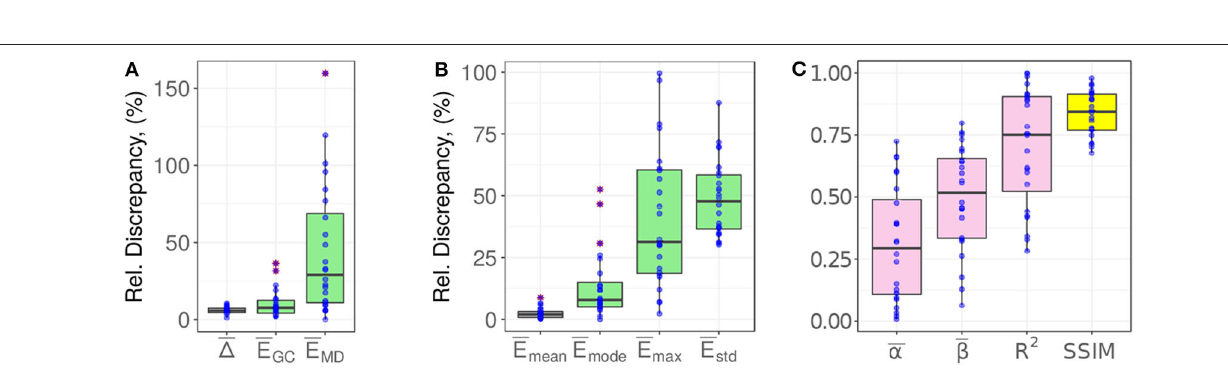
FIGURE 10 | Combined comparison between (A) the predicted and actual depths, and (B) the maximum and mean depths. The data sources and regression relations are marked in the figure legends.